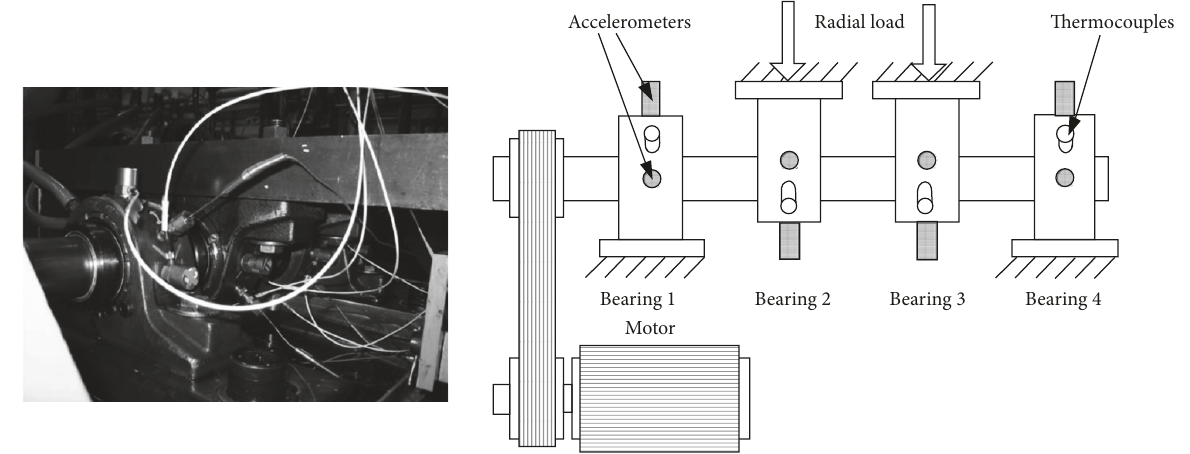
Figure 1: The impact of the parameter 𝛼 .